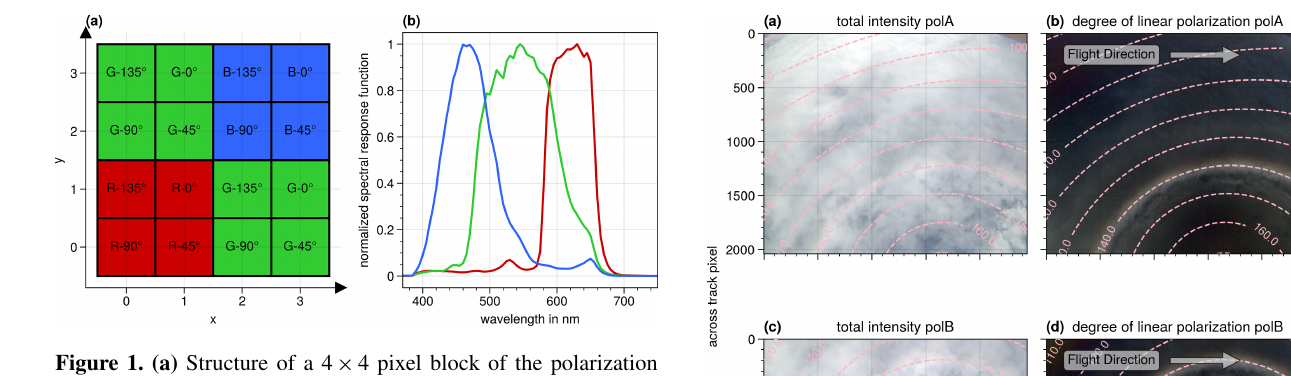
Figure 1. (a) Structure of a 4 × 4 pixel block of the polarization cameras. Each 4 × 4 block is subdivided into four blocks of 2 × 2 pixels for the different colors: red (R), green (G), and blue (B). On the 2 × 2 pixel blocks, four differently angled polarizers are placed. Figure adapted from the datasheet of the camera (LUCID Vision Labs Inc., 2022a). (b) Normalized spectral response functions of the three color channels averaged over the four polarization directions, considering the effect of the camera lens and of the window of the specMACS housing on the spectral response function.